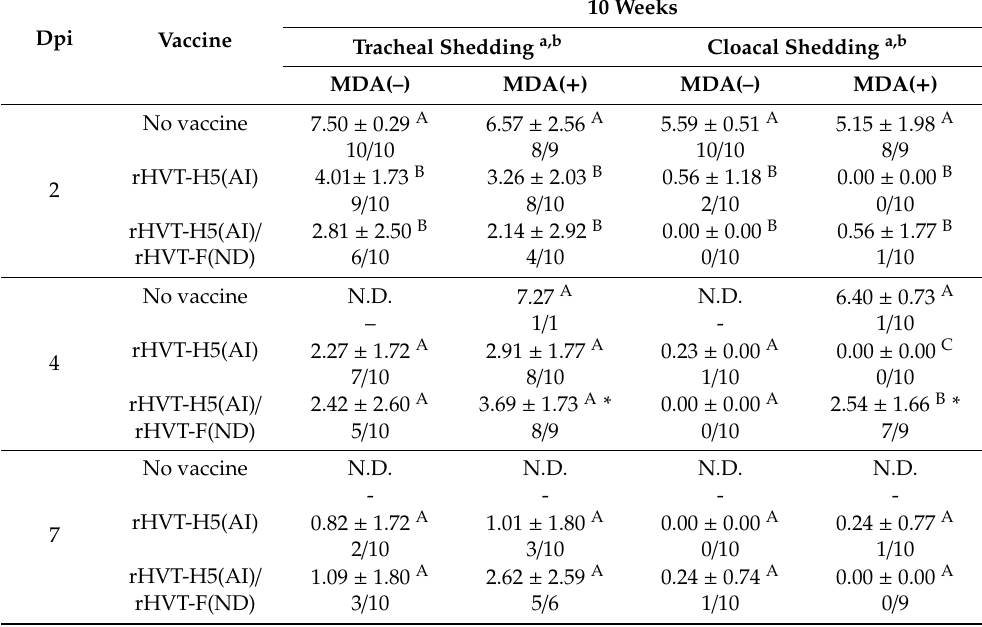
Table 7. Tracheal and cloacal shedding of H5-HPAIV after challenge and at 10 weeks of age with H5-HPAIV to LBL layer chickens (experiment II) vaccinated at day-old with rHVT-F(ND), rHVT-H5(AI), or both